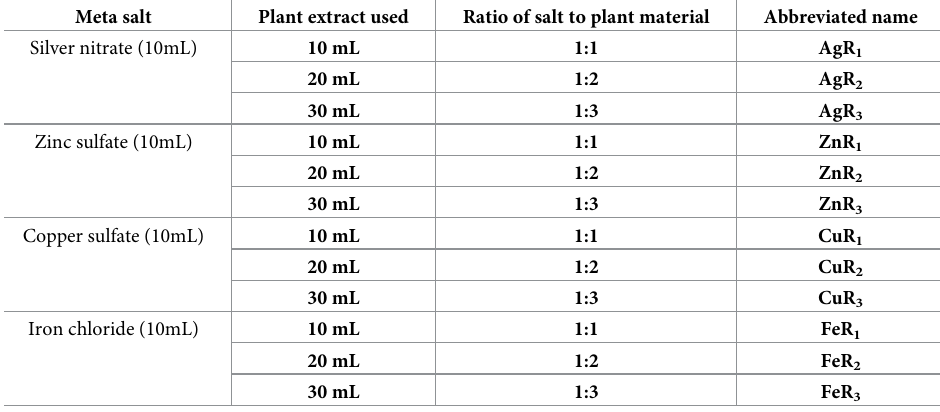
Table 1. Composition of nanoparticles forming